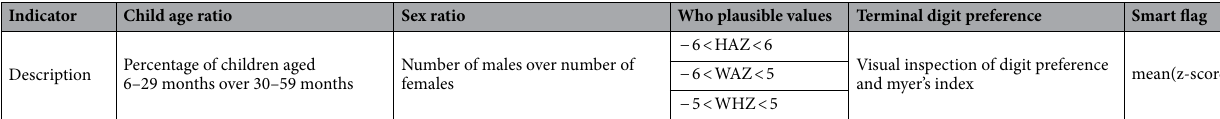
Table 6. Summary of all data quality indicators